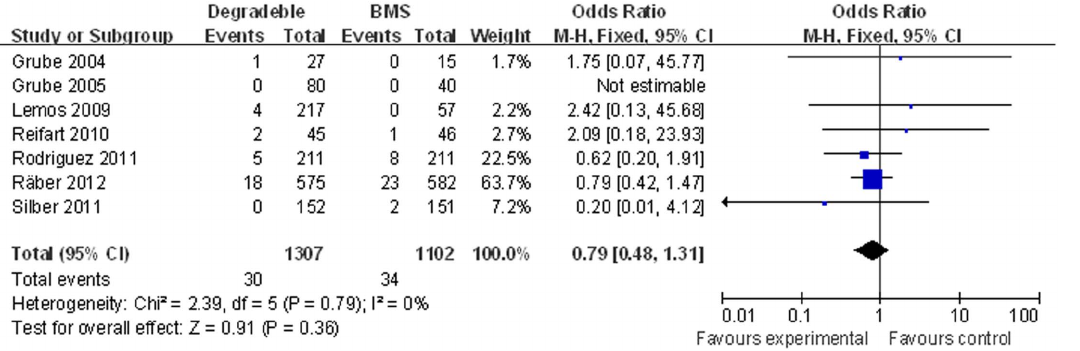
Figure 2. Individual and summary odds ratios for death in patients treated with BP-DES vs. BMS.